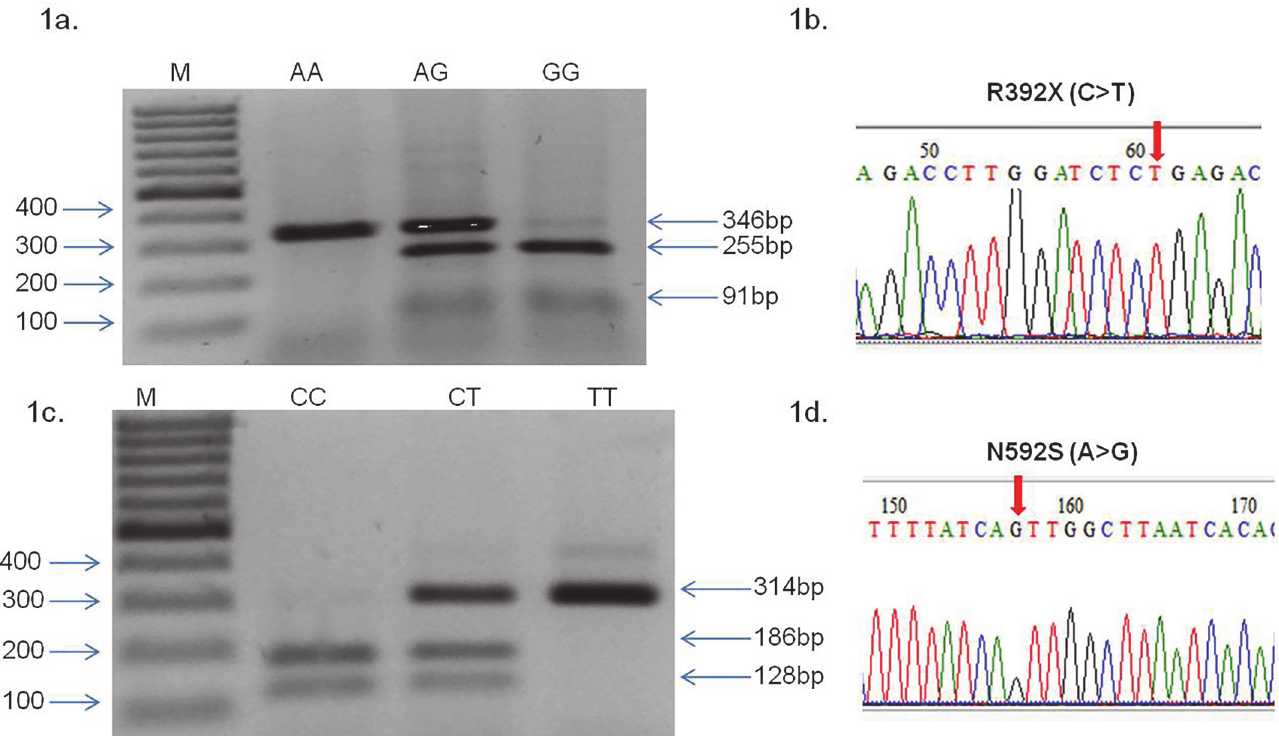
Fig 1. RFLP profiling of TLR5 R392X (C > T), N592S (A > G) and sequencing chromatogram. (1a) 346 bp DNA fragment was amplified by PCR, incubated with Dde1 restriction endonuclease for 12 – 16 hour, R392X (C > T) genotypes were deduced from migration profile on a 2% agarose gel electrophoresis, lane M showing 100bp molecular marker, wild type DNA visible in lane CC with band size 346bp, heterozygous mutant is visible in lane CT with three bands 346+255+91 bp, homozygous mutant (TT) is visible with 255+91 bp band. (1b-1d) Sequencing chromatogram results of TLR5 (1b) R392X (C > T) and (1d) N592S (A > G) SNP. Arrows show position of nucleotide change. (1c) 314 bp DNA fragment was amplified by PCR, incubation with MunI restriction endonuclease for 12 – 16 hr., N592S A > G genotypes were deduced from migration profile on a 2% agarose gel electrophoresis, lane M showing 100